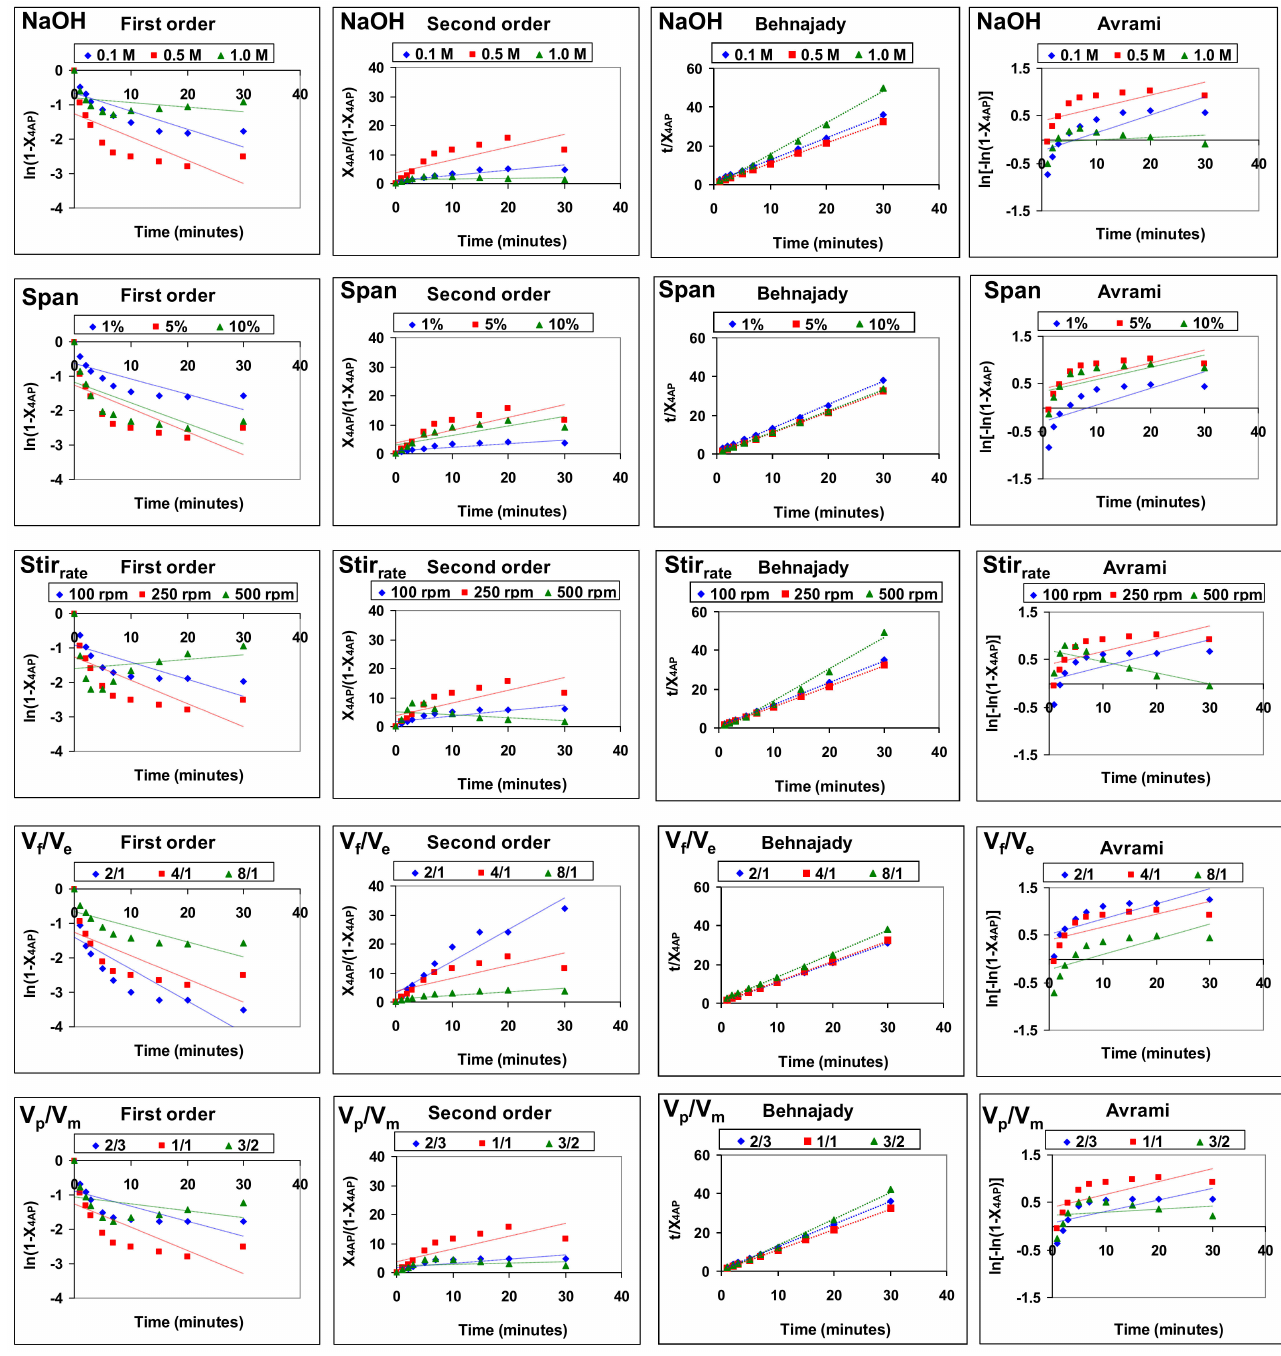
Figure 4. Fitting of the results of 4AP removal by emulsion liquid membranes using basic type 1 facilitation to the four kinetic models studied under the different experimental